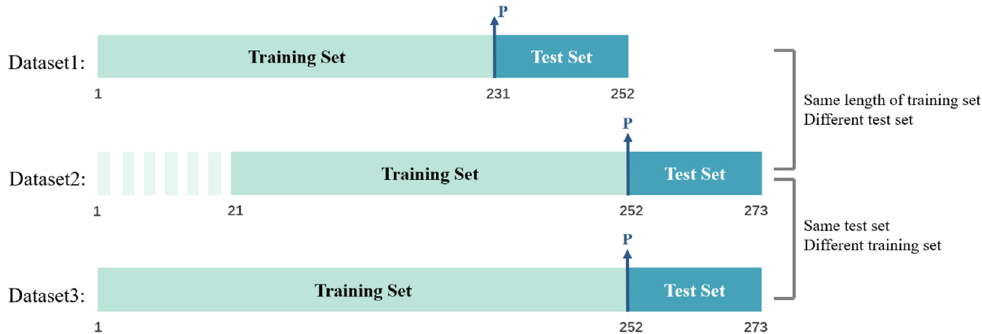
Figure 13. Diagram of the three dataset divisions.